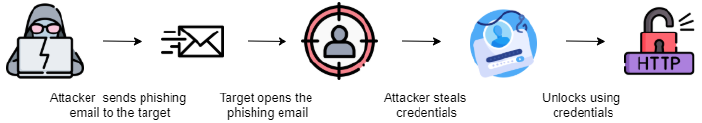
Figure 9. Graphical representation of a phishing attack